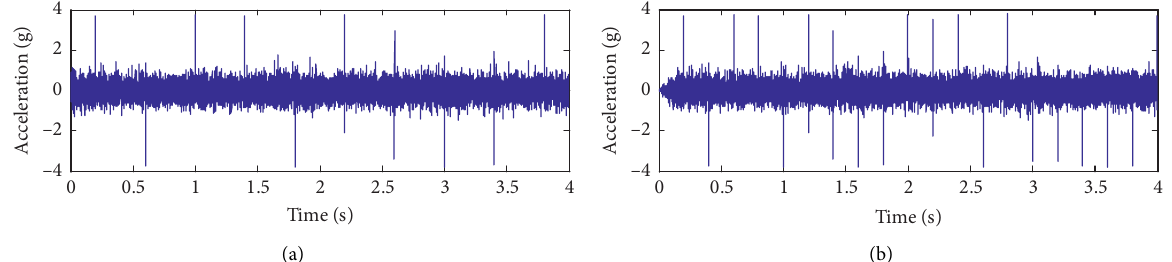
Figure 14: The signal before the WOA operation (a) and the signal after the WOA operation (b).